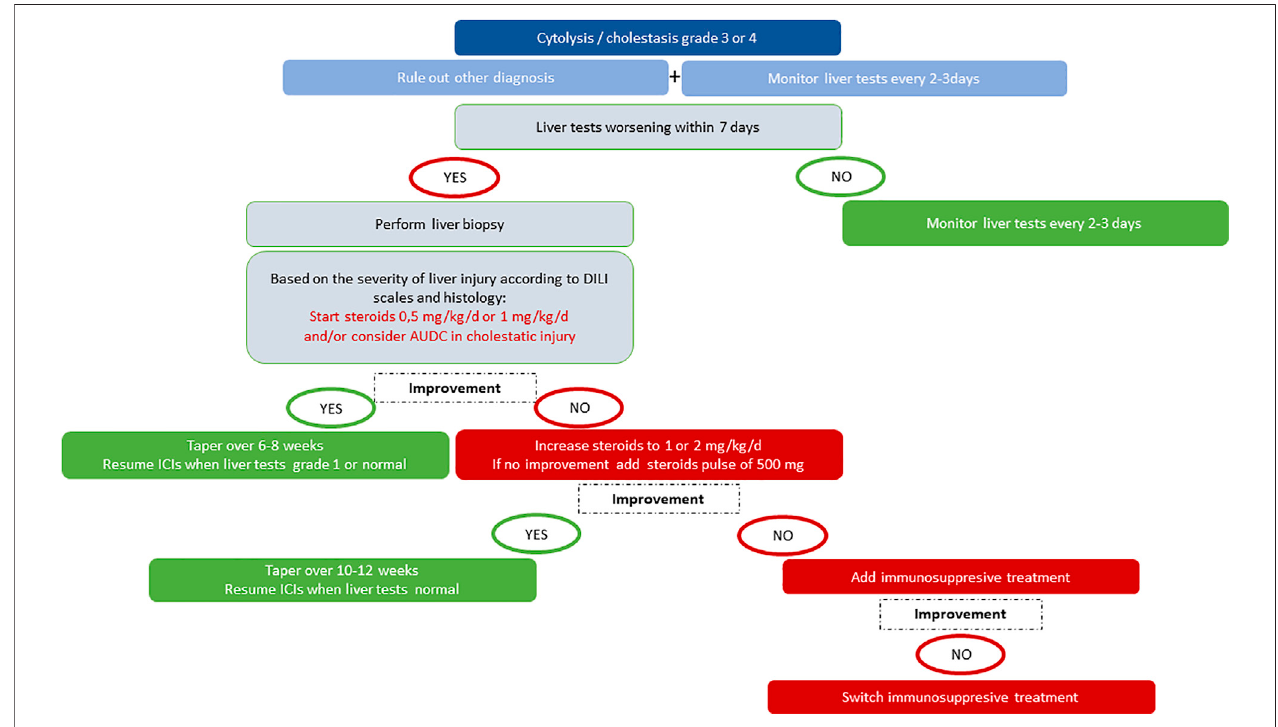
FIGURE 2 | Proposal for the management of grade 3 or 4 ICI-induced liver